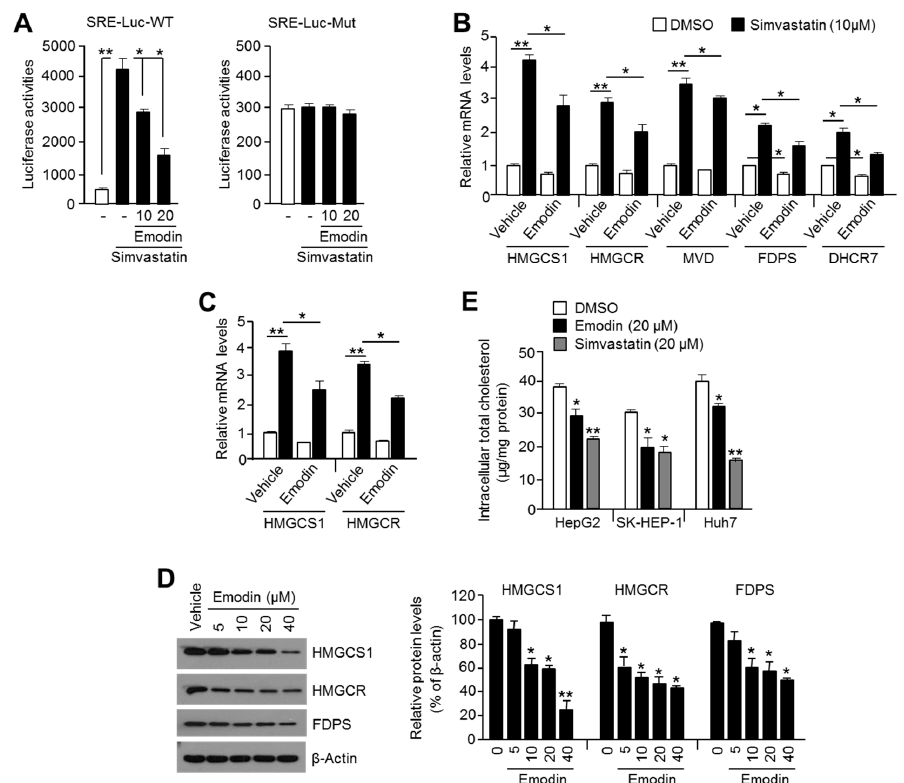
Figure 4. Emodin suppresses SREBP-2 transcriptional activity and decreases intracellular cholesterol. ( A ) The steroid-responsive element (SRE) containing luciferase vectors (SRE–Luc–WT or SRE–Luc–Mut) were transiently transfected into SK-HEP-1 cells. Transfected cells were incubated with 10 or 20 μ M emodin in the absence or presence of 10 μ M simvastatin for 24 h. The values represent the mean ± SD of three independent experiments performed in duplicate; * p < 0.05 and ** p < 0.01. ( B ) The suppressive effect of emodin on simvastatin-induced cholesterogenic gene expression. SK-HEP-1 cells were incubated with 20 µ M emodin in the absence or presence of 10 µ M simvastatin for 24 h. The gene expression was measured by quantitative real-time PCR, and relative mRNA expression was normalized to the expression of 36B4. The values represent the mean ± SEM of three independent experiments performed in triplicate; * p < 0.05 and ** p < 0.01. ( C ) The suppressive effect of emodin on simvastatin-induced cholesterogenic gene expression in HepG2 cells. ( D ) The inhibitory effect of emodin on cholesterogenic enzyme expression in SK-HEP-1 cells. The cells were incubated with 5, 10, 20, or 40 µ M emodin for 24 h, and protein expression was analyzed by Western blotting, as described in the mean ± SD of three independent experiments performed; * p < 0.05 and ** p < 0.01. ( E ) Intracellular cholesterol level after emodin treatment. Three HCC cell lines were cultured for 48 h in the absence or presence of 20 µ M emodin or 20 µ M simvastatin. The values are presented as the mean ± SD of three independent experiments performed in duplicate; * p < 0.05 and ** p <